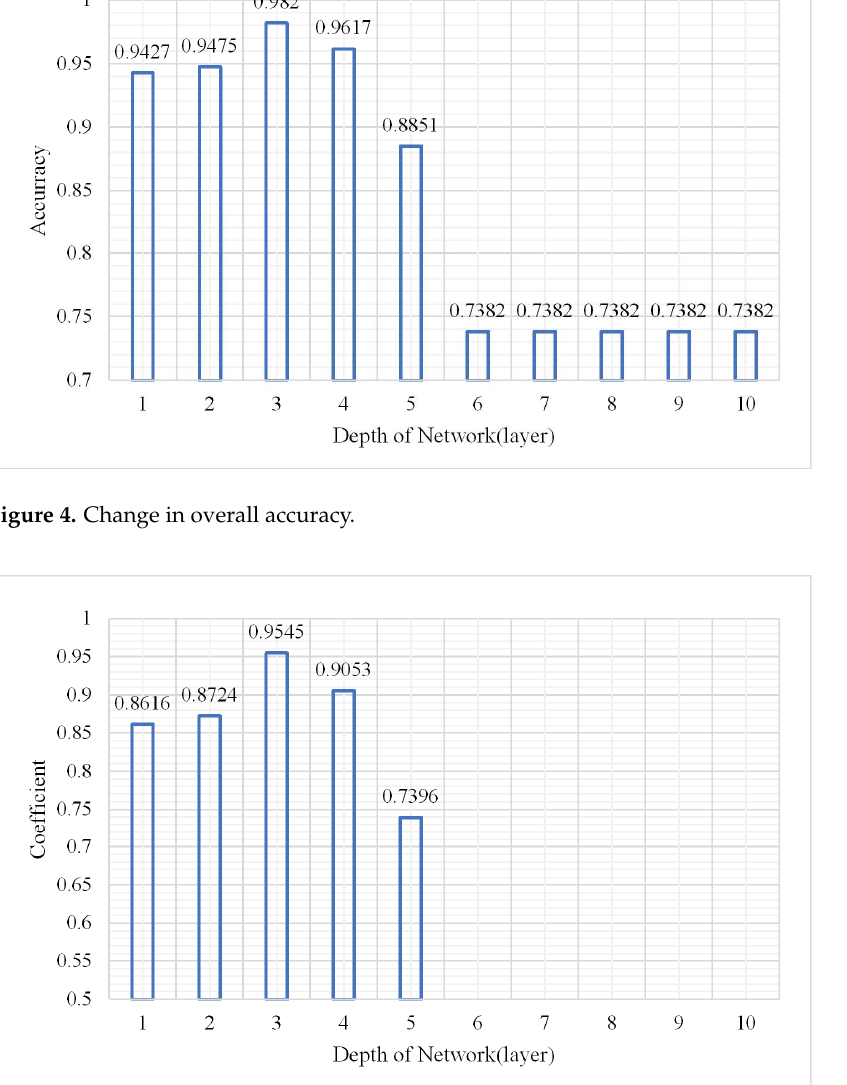
Figure 5. Change in kappa coefficient.